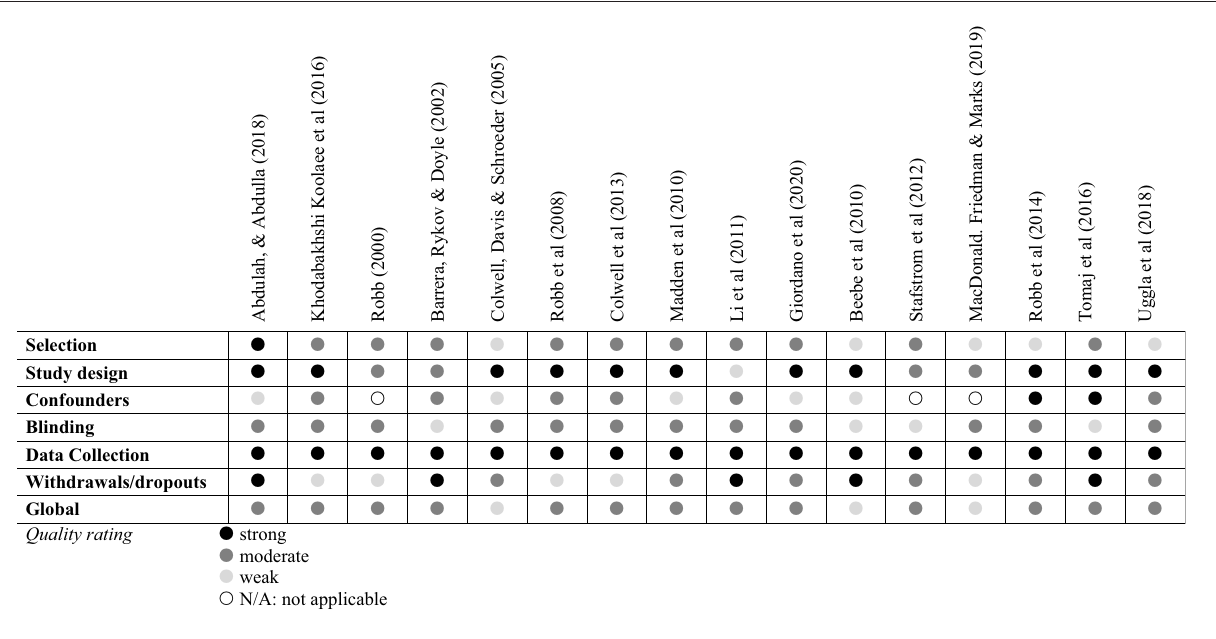
FIGURE 2 | Quality assessment of studies included in the